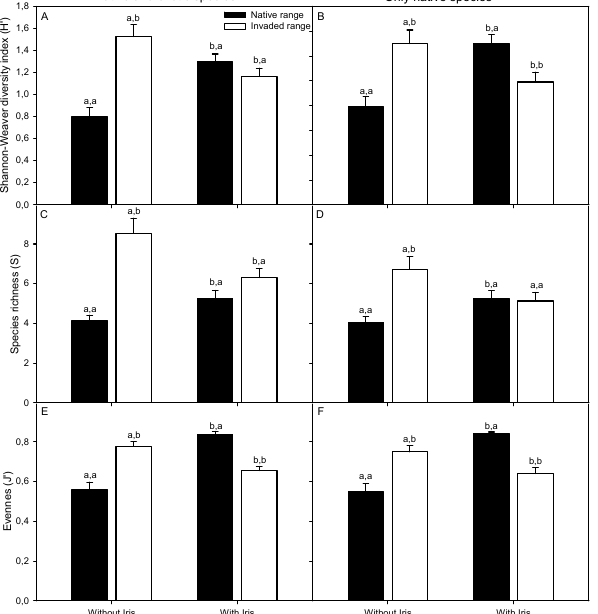
Figure 4. Shannon – Wiener α -diversity (H’) ( A , B ), species richness (S) ( C , D ) and J’ evenness ( E , F ) with and without Iris pseudacorus in its native (Guadalquivir Estuary) and invaded (San Francisco Bay-Delta Estuary) distribution ranges, analyzing both native and exotic species ( A , C , E ) and only native species ( B , D , F ). Different letters indicate significant differences between paired plots with I. pseudacorus presence or absence within each range (first letter) and between ranges (second letter) ( t -test or U-test, p < 0.05). Values are mean ± SE ( n = 38–39).